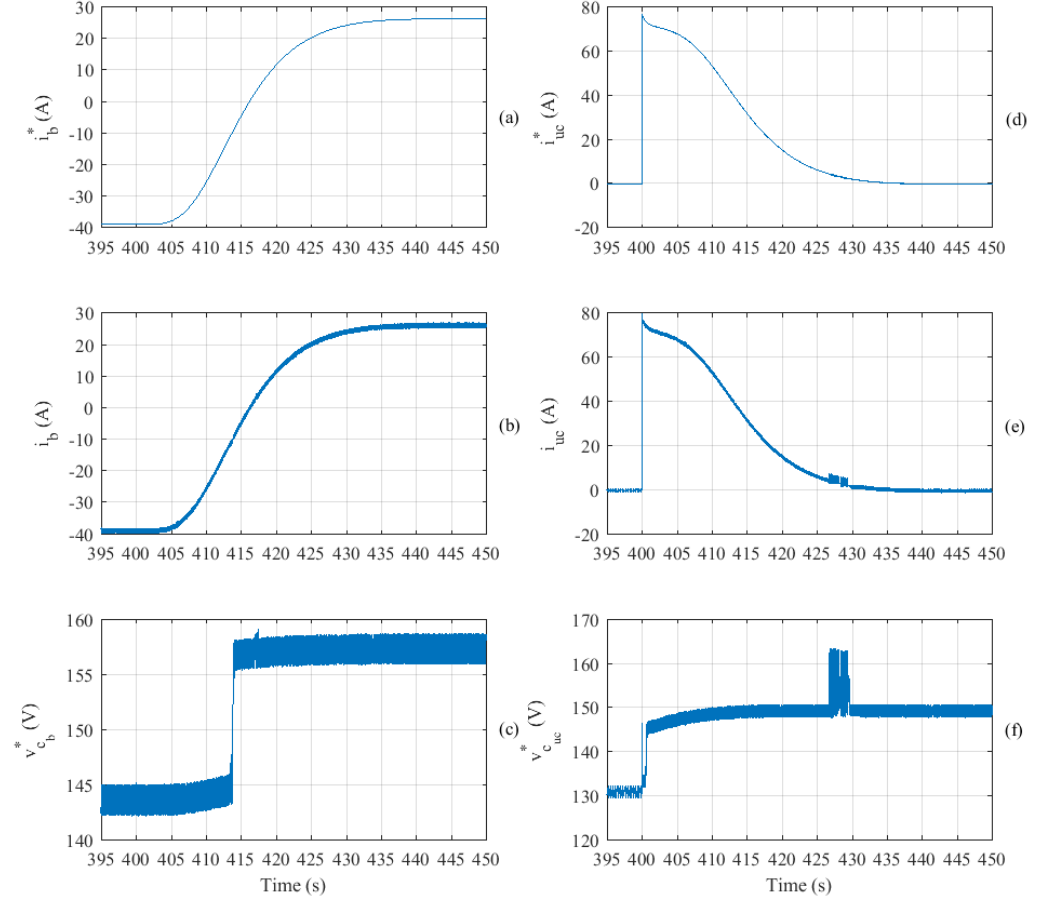
Figure 24. Results obtained for CPV 1 . Time responses of ( a ) reference of the battery current, i ∗ ( b ) current of the batteries, i b ; ( c ) reference voltage for the DC–DC converter associated to the bank of the batteries, v ∗ c ; ( d ) reference of the ultracapacitor current, i ∗ uc ; ( e ) current of the ultracapacitors, i uc ; b and ( f ) reference voltage for the DC–DC converter associated to the ultracapacitors, v ∗ c